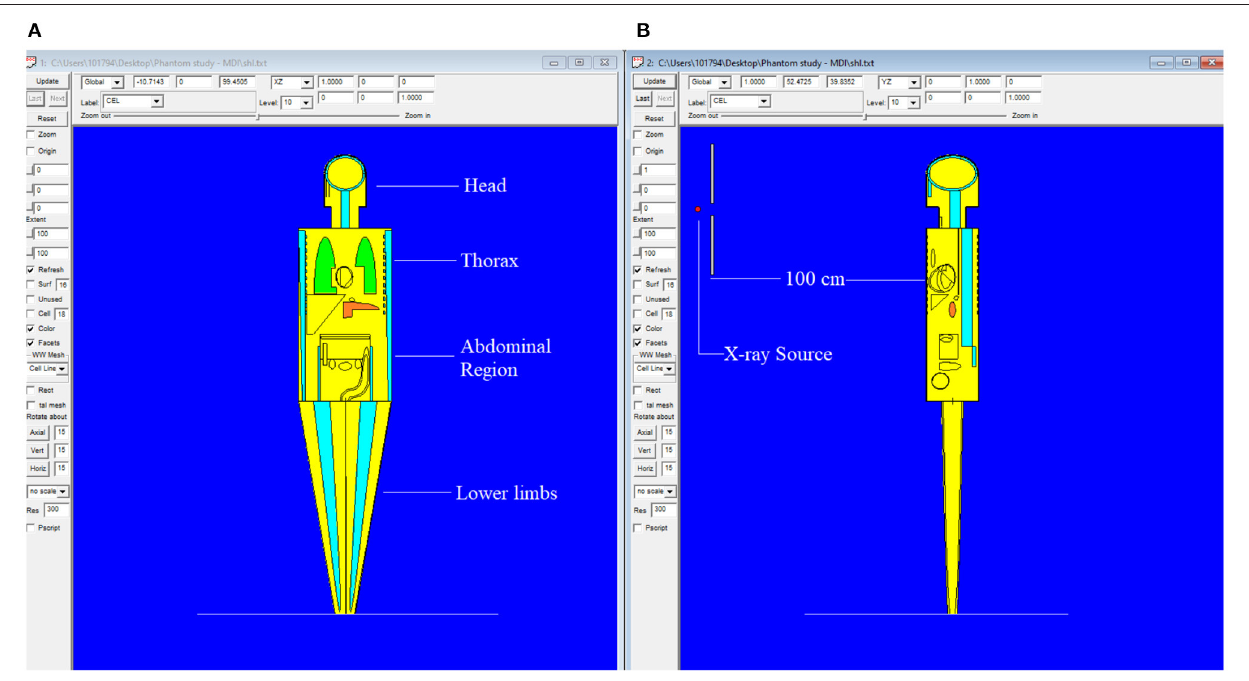
FIGURE 1 | MIRD phantom utilized in this research using MCNPX general purpose Monte Carlo code ( version 2.7.0 ) (A) Antero-posterior view of MIRD phantom (B) Lateral view of MIRD